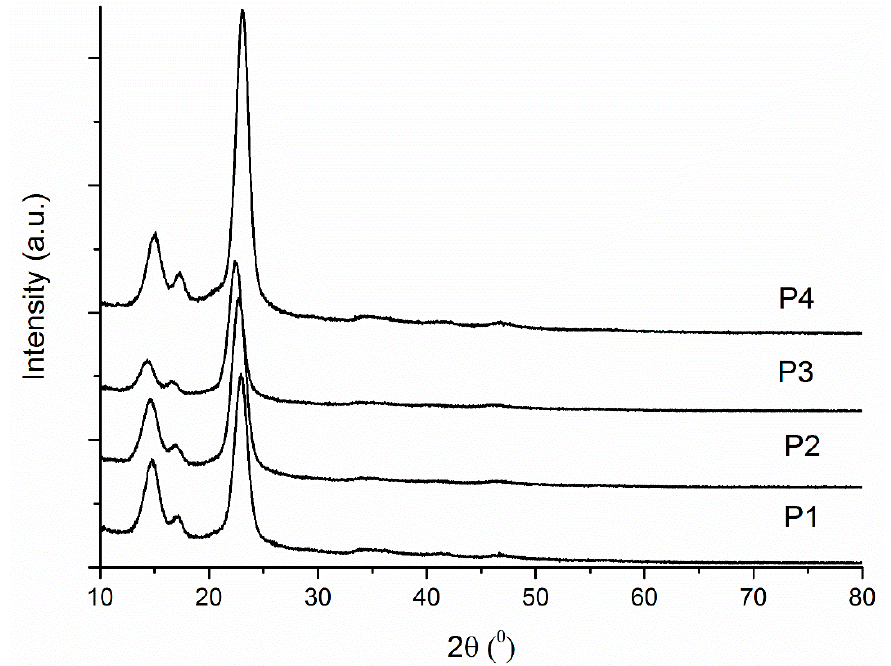
Figure 4. X-ray diffractograms for P1–P4